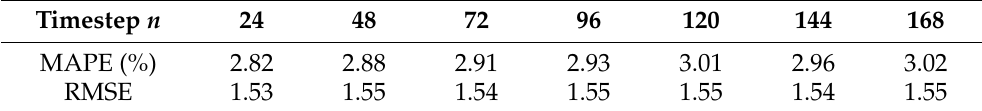
Table 7. Evaluation indices of the seq2seq module under different lengths of input